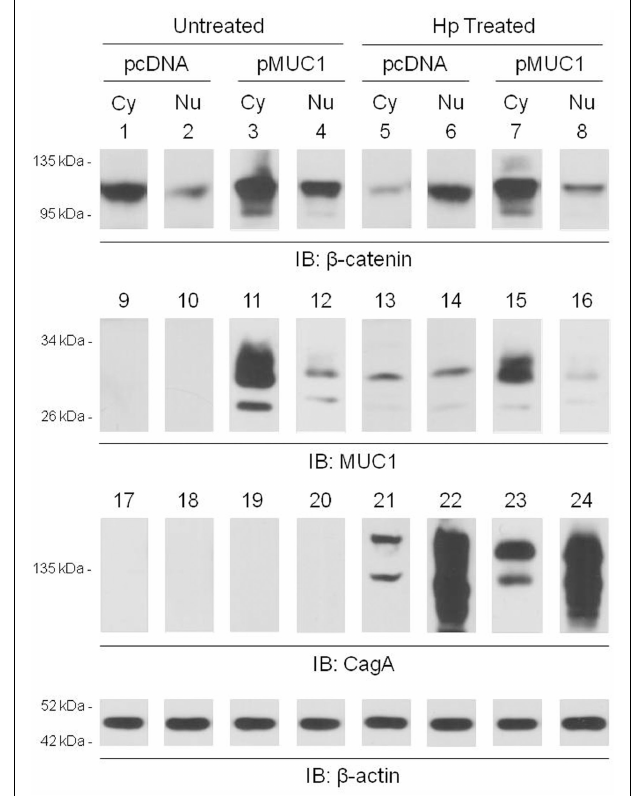
FIGURE 5 | MUC1 over-expression inhibits H. pylori -dependent increased nuclear β -catenin level. AGS cells were transfected with the pcDNA empty vector or the pMUC1 expression plasmid. At 24h post-transfection, the cells were untreated or were treated with H. pylori (Hp) at an MOI of 100. At 24h post-infection, the cells were washed, cytoplasmic (Cy) and nuclear (Nu) lysate fractions were prepared, and immunoprecipitated with antibodies to β -catenin (lanes 1–8), MUC1 (lanes 9–16), or CagA (lanes 17–24).To control for to control for protein loading and transfer, blots were stripped and reprobed with antibody to β -actin. Molecular weight markers are indicated on the left in kilodaltons (kDa).The results are representative of two